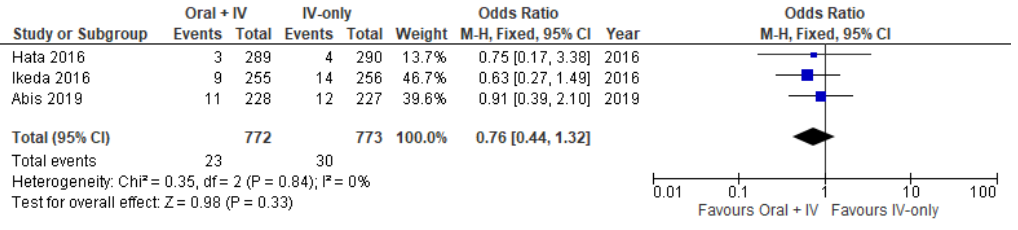
Figure 9. Forest plot of bowel obstruction comparing oral + IV group and IV-only group.